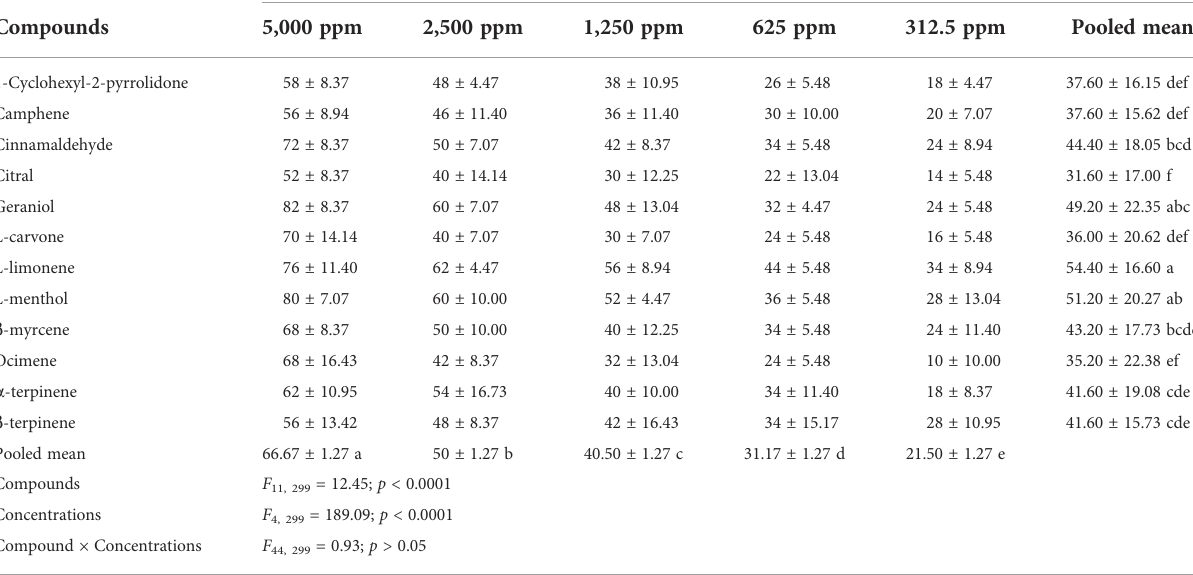
Mean of fi ve replications: Means followed by the same letters within a column are not statistically signi fi cant (p > 0.05) by Tukey ’ s